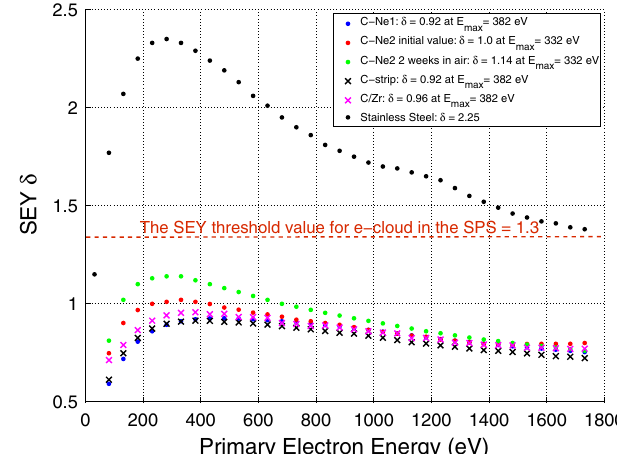
FIG. 3. Overview of the SEY of a-C coatings and StSt refer- ence sample. The threshold value for e-cloud in the SPS with the LHC beams is 1.3